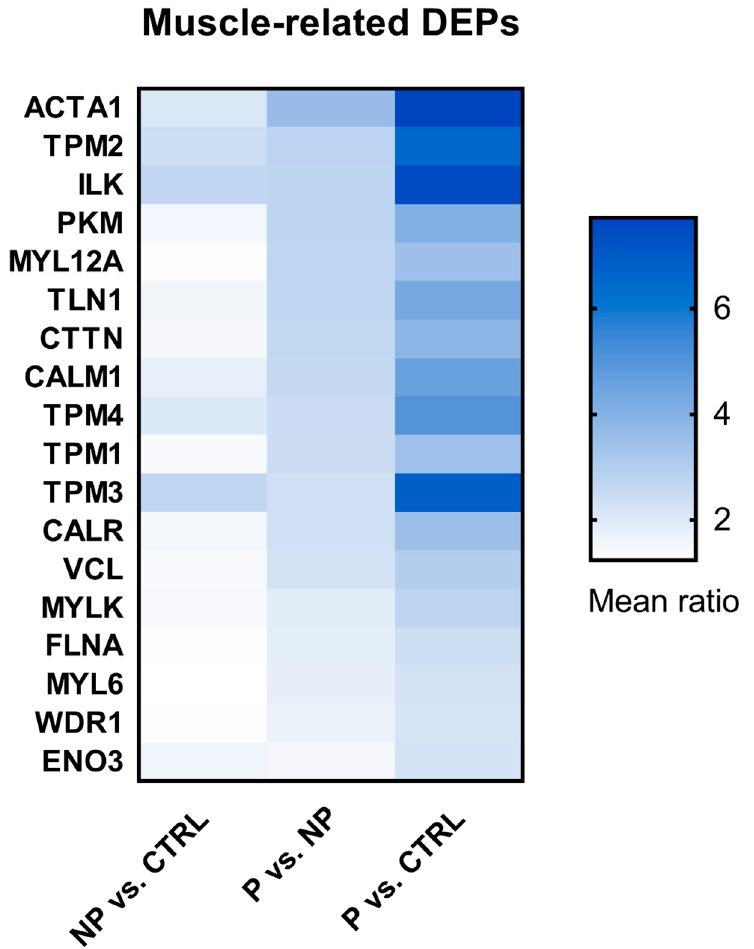
Figure 3. Heatmap of the upregulated DEPs that are functionally related to muscle. The DEPs are listed, sorted by the mean ratio of the P vs. NP groups. The mean ratio was calculated as the mean of four ratio values, e.g., the mean ratio of NP vs. CTRL = (NP_1/CTRL_1 + NP_1/CTRL_2 + NP_2/CTRL_1 + NP_2/CTRL_2)/4.